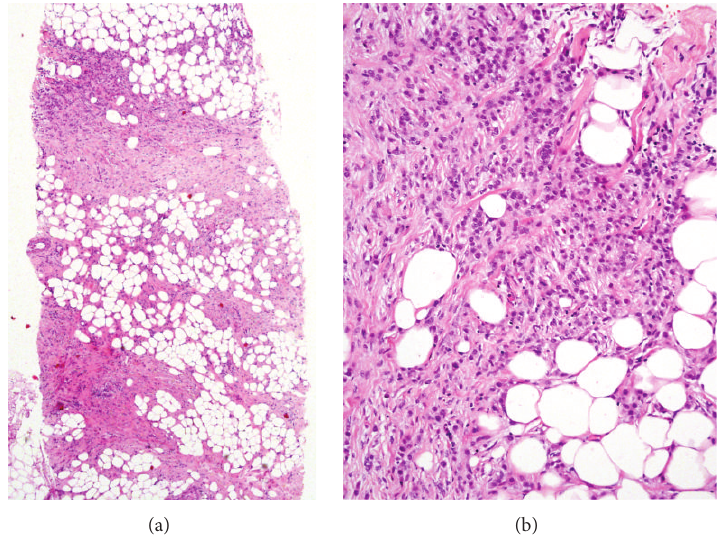
Figure1:(a)Lowpowerand(b)mediumpowermicroscopicviewsofthebreastcorebiopsyshowinginvasivelobularcarcinoma(hematoxylin and eosin stained section, magnifications × 40 and × 200